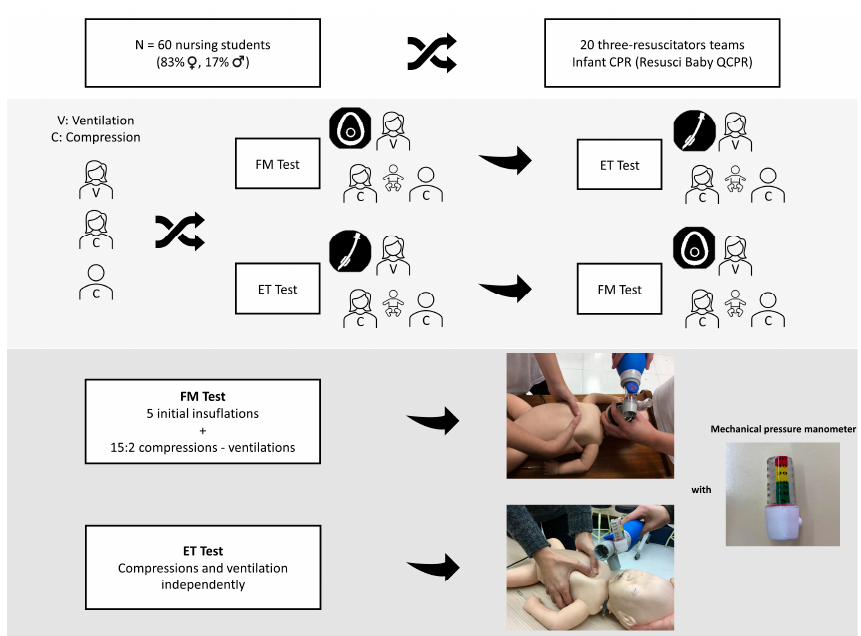
Figure 1. Study design flow-chart. (FM: face mask; ET: endotracheal tube).